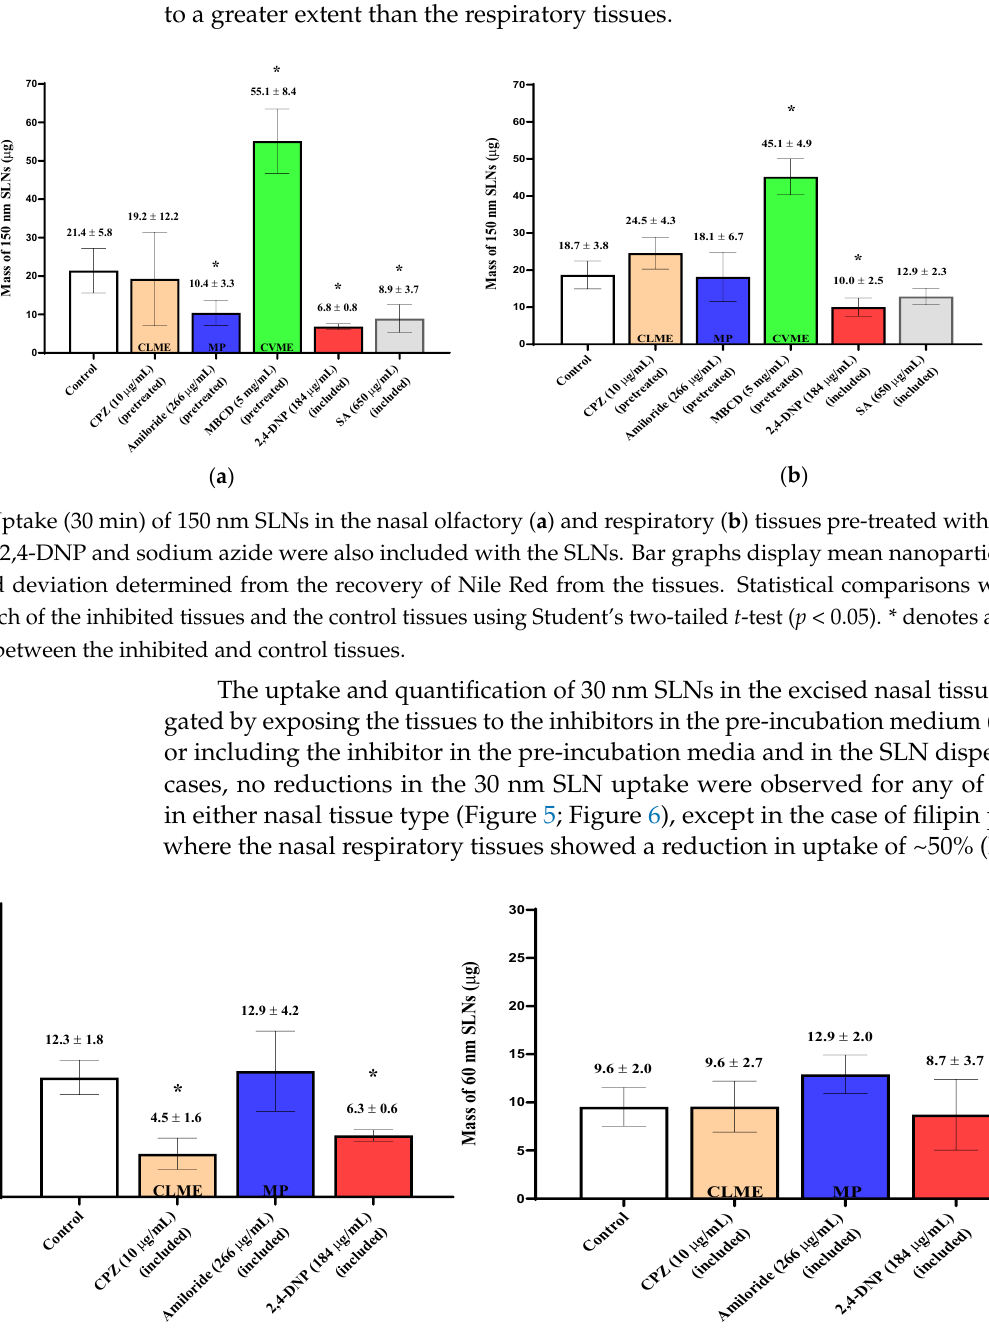
Figure 4. Uptake (30 min) of 60 and 30 nm SLNs in the nasal olfactory ( a ) and respiratory ( b ) tissues pre-treated with filipin. Bar graphs display mean nanoparticle uptake ± standard deviation determined from the recovery of Nile Red from the tissues. Statistical comparisons were made between the inhibited and control tissues using Student’s two-tailed t -test ( p < 0.05). * denotes a significant statistical difference between the inhibited and control tissues. In addition to measuring the uptake of SLNs into the nasal mucosal tissues, the re- ceiver chambers of the NaviCyte ® cells were sampled to measure SLN transfer through and exit from the tissues. The Nile Red fluorescence measurements in the receiver cham- ber were indistinguishable from the control KRB medium, indicating that virtually no na- noparticles exited the excised tissues. Since there are limited mechanisms or pathways available in the submucosal tissues to assist in the transfer of the nanoparticles out of the tissues, the lack of appearance of materials in the receiver chamber should not be inter- preted to mean that there will be no systemic transfer of those particles in vivo. Since the blood and lymph vessels involved in the systemic distribution of materials absorbed via the nasal mucosa lie within the submucosal region, transfer into these vessels is likely, even if escape from the tissues in the experimental system was not observed.